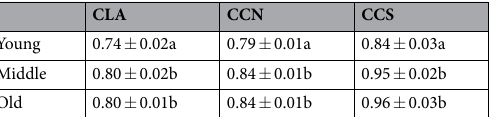
Table 2. CLA, CCN and CCS of soybean planted in shade. CLA (change of leaf area) = (leaf area of shade plants)/(leaf area of full sunlight plants). CCN (change of cell number) = (cell number of shade plants)/(cell number of full sunlight plants). CCS (change of cell size) = (cell size of shade plants)/(cell size of full sunlight plants). Data are means ± SD (n = 4). Statistical significance assessed by Duncan’s t-test. Letters on each row represents a significant level of 0.01 (p <